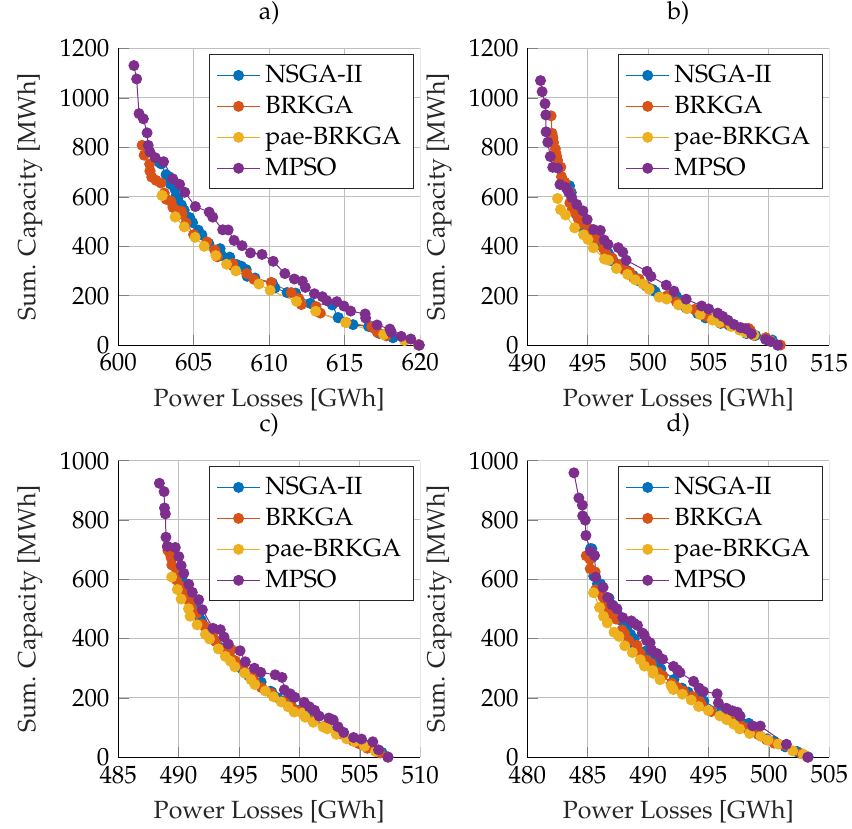
Figure 10. Pareto Front determined by means of the NSGA-II, MPSO, BRKGA and pa (cid:101) − BRKGA methods for: ( a ) Test Case 1; ( b ) Test Case 2; ( c ) Test Case 3; ( d ) Test Case